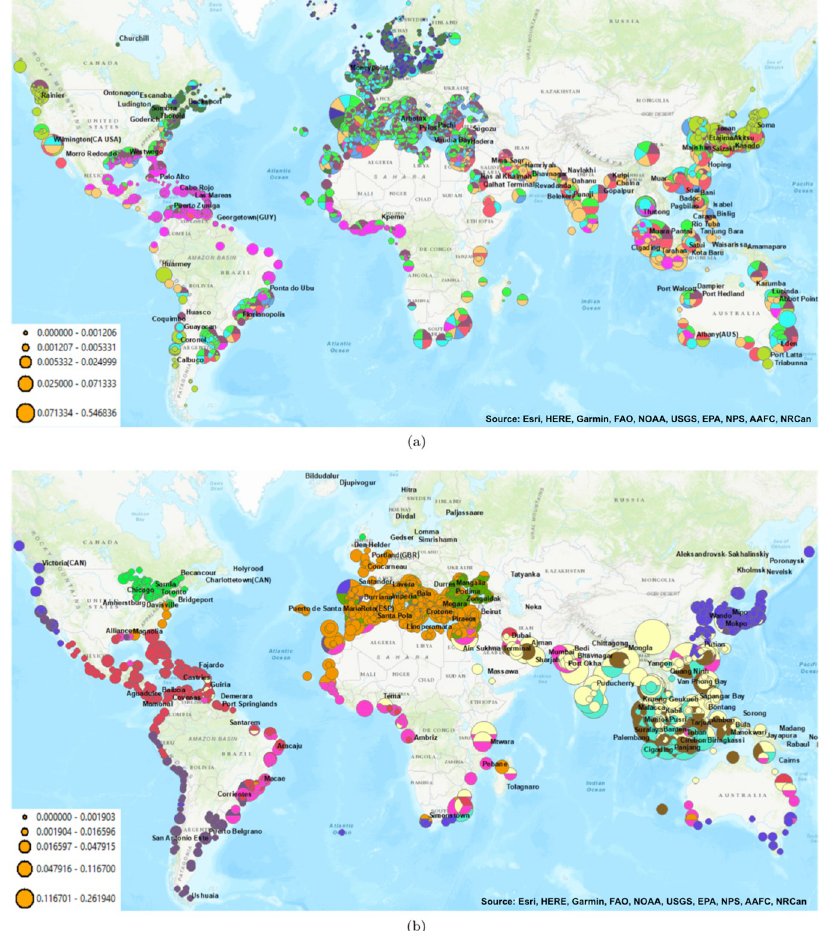
Fig 4. The diverse higher-order clustering of shipping ports based on the ballast discharge risks (a) and higher- order clustering of biofouling risks (b). The coloring of the ports indicates the port cluster. Ports which belong to multiple clusters through the higher-order patterns are shown as a pie chart with multiple colors. The pie chart size indicates the relative NIS spread risk for the port. The top ports with the highest risk are labeled by name.